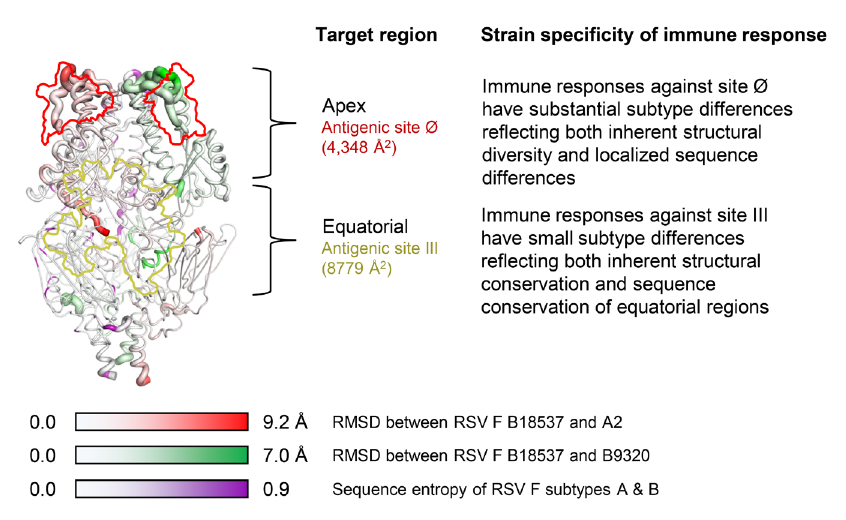
Figure 8. Schematic of RSV F highlighting structural features and subtype differences in immunoge- nicity. A composite RSV F trimer comprising a subunit each from the structures of B18537, B9320 (PDB 5UDE), and A2 (PDB 4MMU) shows a shape similar to the individual structures. Each subunit is shown as worm representation with thickness indicating B factor values. On the subunit of B18537 is mapped the RMSD between the structures of B18537 and A2 F in a gradient of red; on that of B9320, the RMSD between the structures of B18537 and B9320 F in a gradient of green; and on that of A2 is mapped the se- quence entropy of RSV F subtypes A and B sequences in a gradient of purple. The positions of sites Ø and III on the front face are marked with contours in red and pale-yellow,